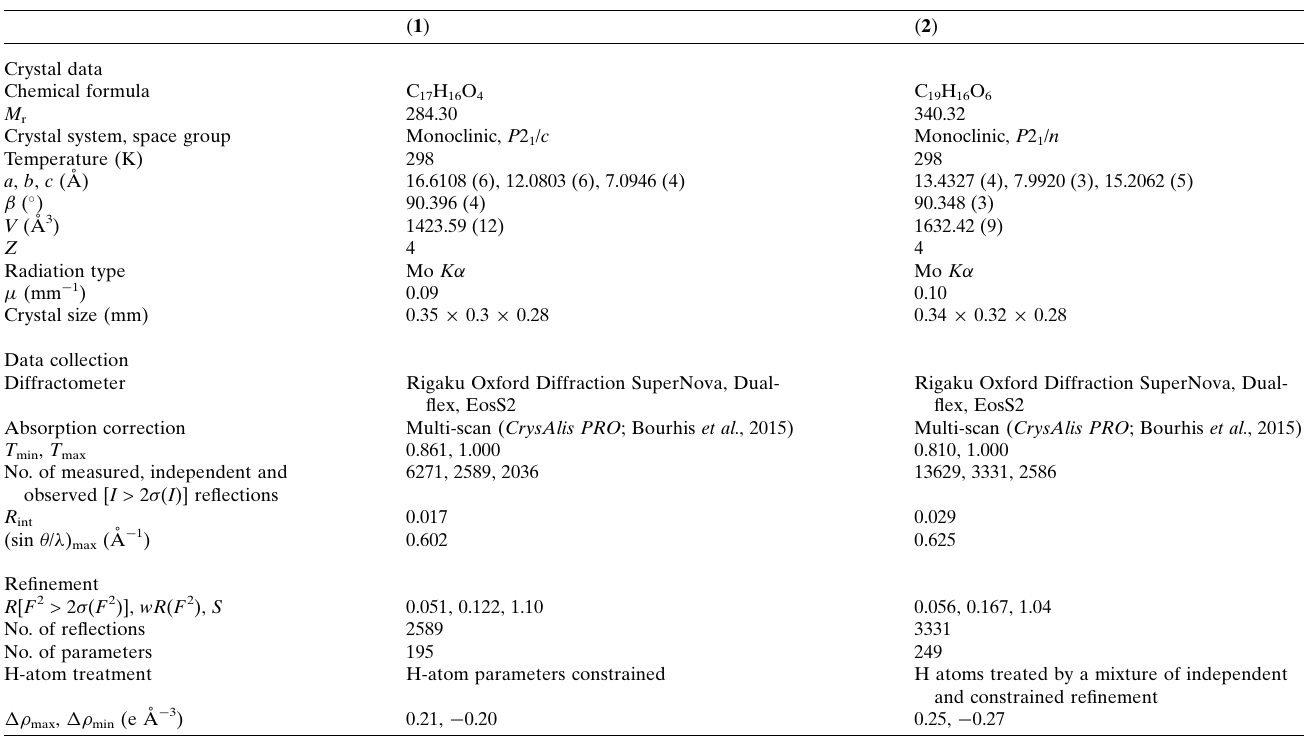
Table 3 Experimental details.